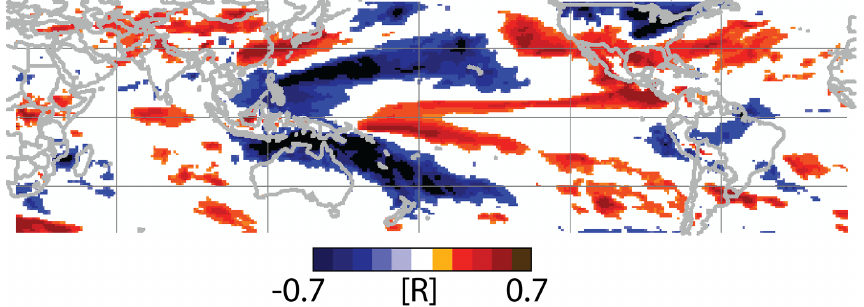
Figure 3. Spatial pattern of correlation between CFSv2 precipitation forecasts for the MAM season (initialized in February) and observed MAM rainfall (CHIRPS) in the focus domain. Correlation values have been masked for significance (values r < | 0.35 | have been